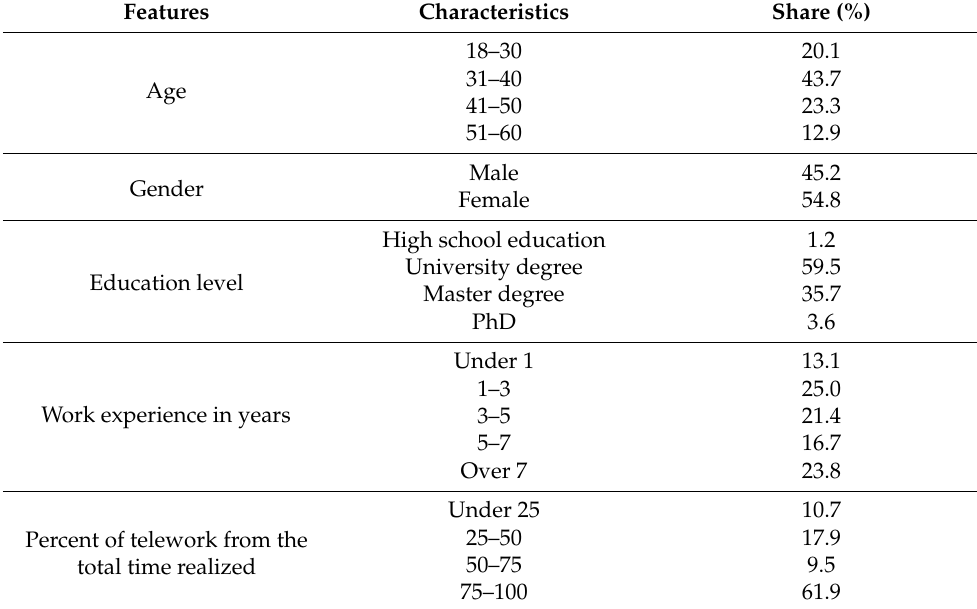
Table 1. Sociodemographic characteristics of the execution staff from 2021.